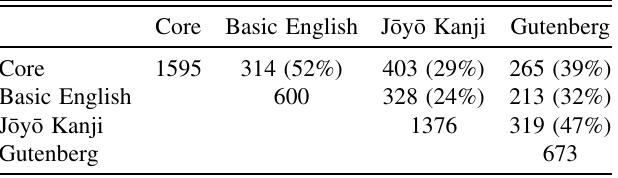
TABLE I. Intersection of the core with other simple word lists. Table entries represent the number of words in the intersection of the sets, with percent overlap given in parentheses. The core is obtained using a simplified WordNet dictionary graph, in which nodes were words (not synsets), with only the first sense of the definition considered. This method yields a graph with lower resolution than the one obtained using the sense-disambiguated data from eXtended WordNet. We use it because the lists we compare to are not sense-disambiguated. Only nouns in each word list are considered. Descriptions of the word lists are found in the main text.